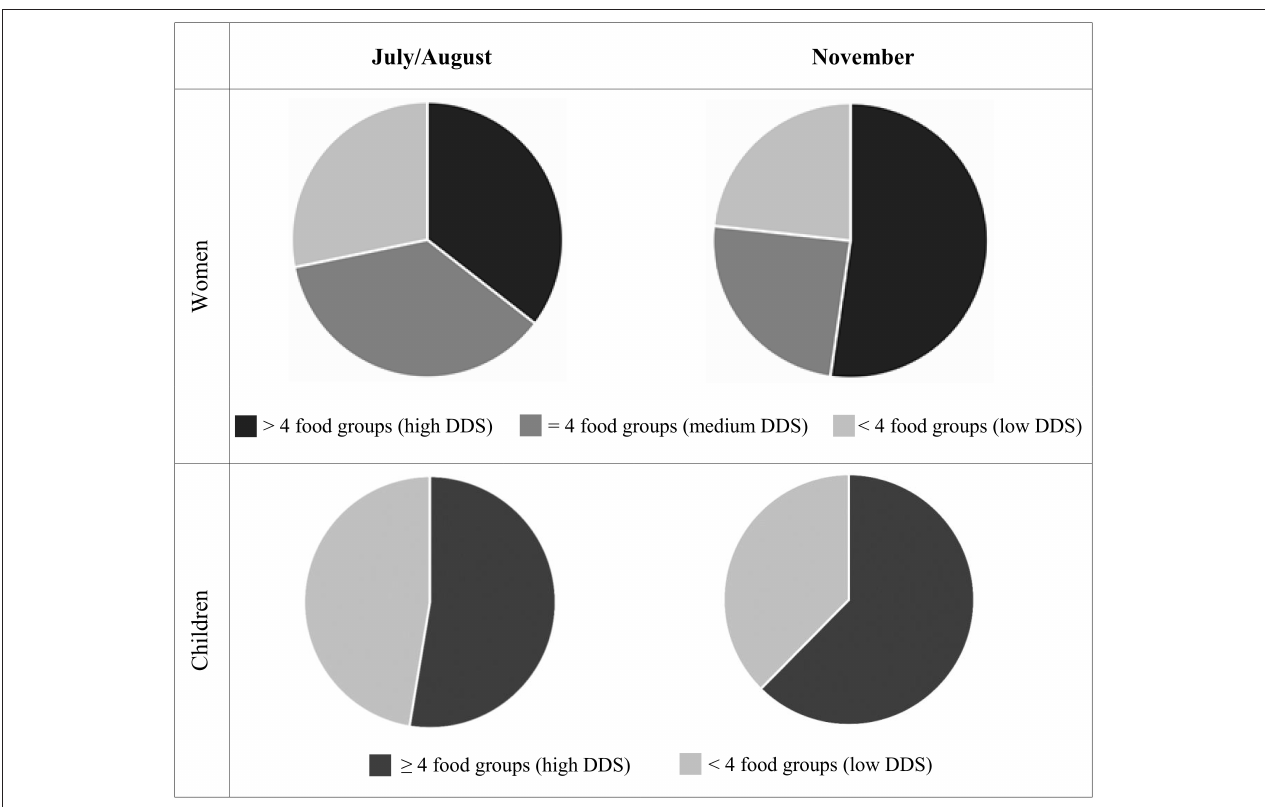
FIGURE 2 | Distribution of Dietary Diversity Scores (DDS) and proportion of women ( n = 426) who had diets with low ( < 4 food groups), medium ( = 4 food groups) and high ( > 4 food groups) DDS and children ( n = 426) who consumed diets with high ( ≥ 4 food groups) and low ( < 4 food groups) dietary diversity and in July/August and November